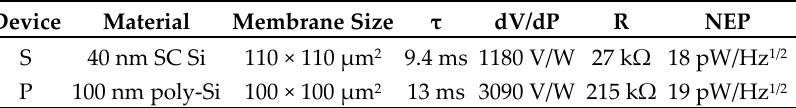
Table 1. Characteristics of device S [1] and